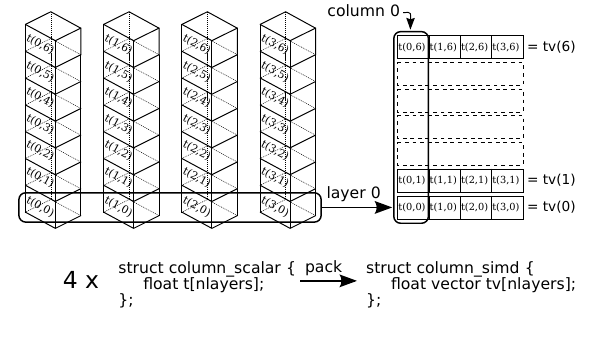
Fig. 2. Four instances of the array variable t , which extends over all layers of the column, are packed together into a single array of vectors. Fig. 1. A schematic overview of the CELL processor. The Pow- erPC Processing Element (PPE) and eight Synergistic Processing